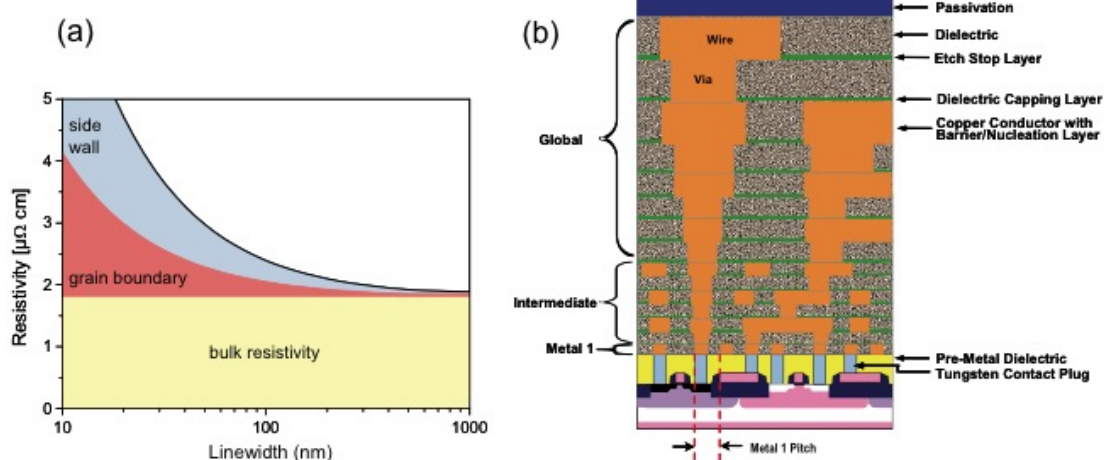
Figure 1. ( a ) Resistivity of copper as function of the interconnect linewidth; ( b ) Typical cross-section of hierarchical scaling (microprocessor unit (MPU) device) showing different interconnect scaling levels